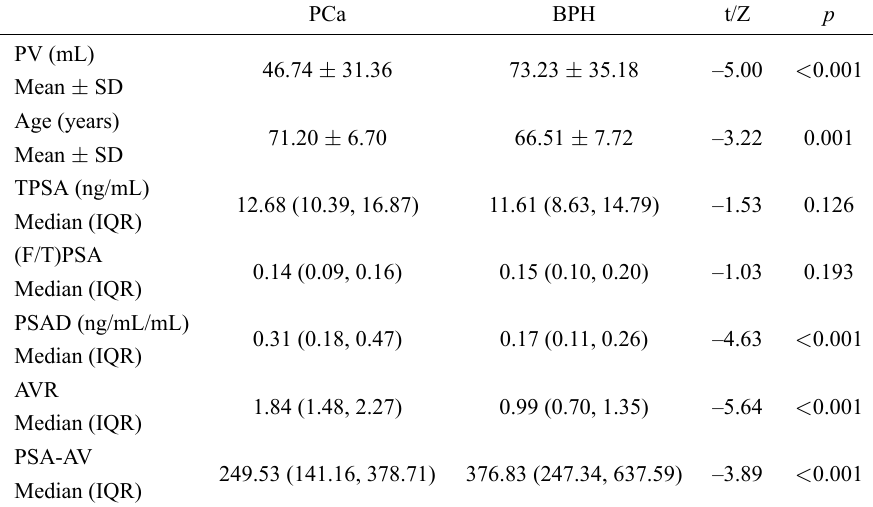
Table 1. Baseline clinical data in the PCa and BPH